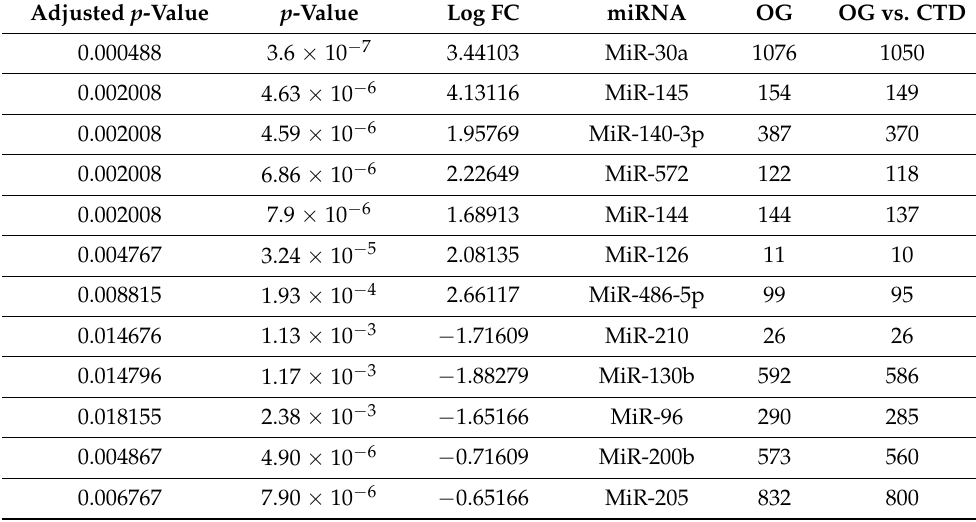
Table 2. Top 12 DEMs (7 downregulated and 5 upregulated) on the basis of log fold change and p -value. Upregulated miRs are miR-210, miR-130b, miR-96, miR-200b and miR-205 and downregu- lated miRs are miR-30a, miR-145, miR-140 3p, miR-572, miR-144, miR-126 and miR-486-5p. p -Value Log